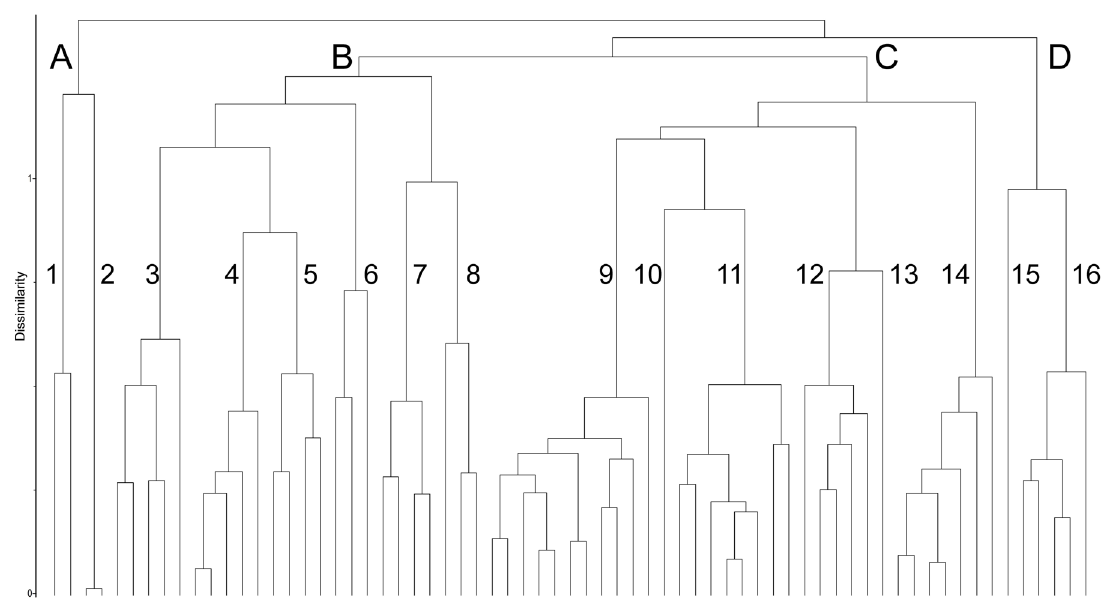
Figure 4. Cluster analysis of relevés of aquatic vegetation (cover data, Chord distance, UPGMA): 1, Lemnetum minoris ; 2, Cera- tophylletum demersi ; 3, Lemnetum trisulcae ; 4, Potamo perfoliati-Ranunculetum fluitantis ; 5, Ranunculo